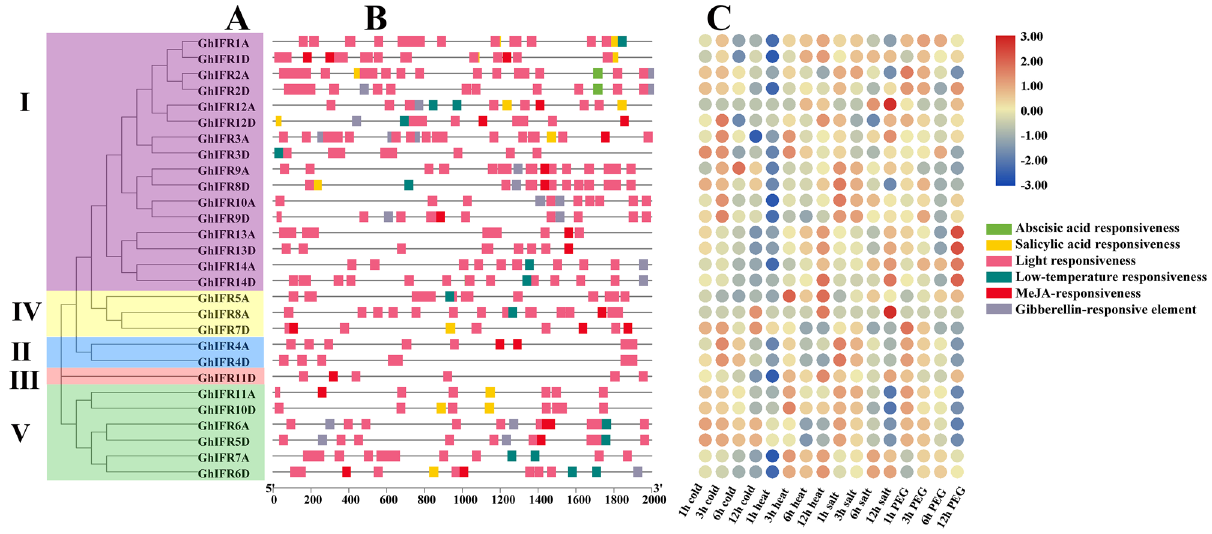
Figure 6. Phylogenetic tree, cis -acting elements and heat map analysis of GhIFR genes in G. hirsutum. (A) Phylogenetic tree of GhIFR genes, (B) Cis -acting elements in promoters of GhIFR genes, (C) Heatmap of GhIFR genes under different abiotic stresses.